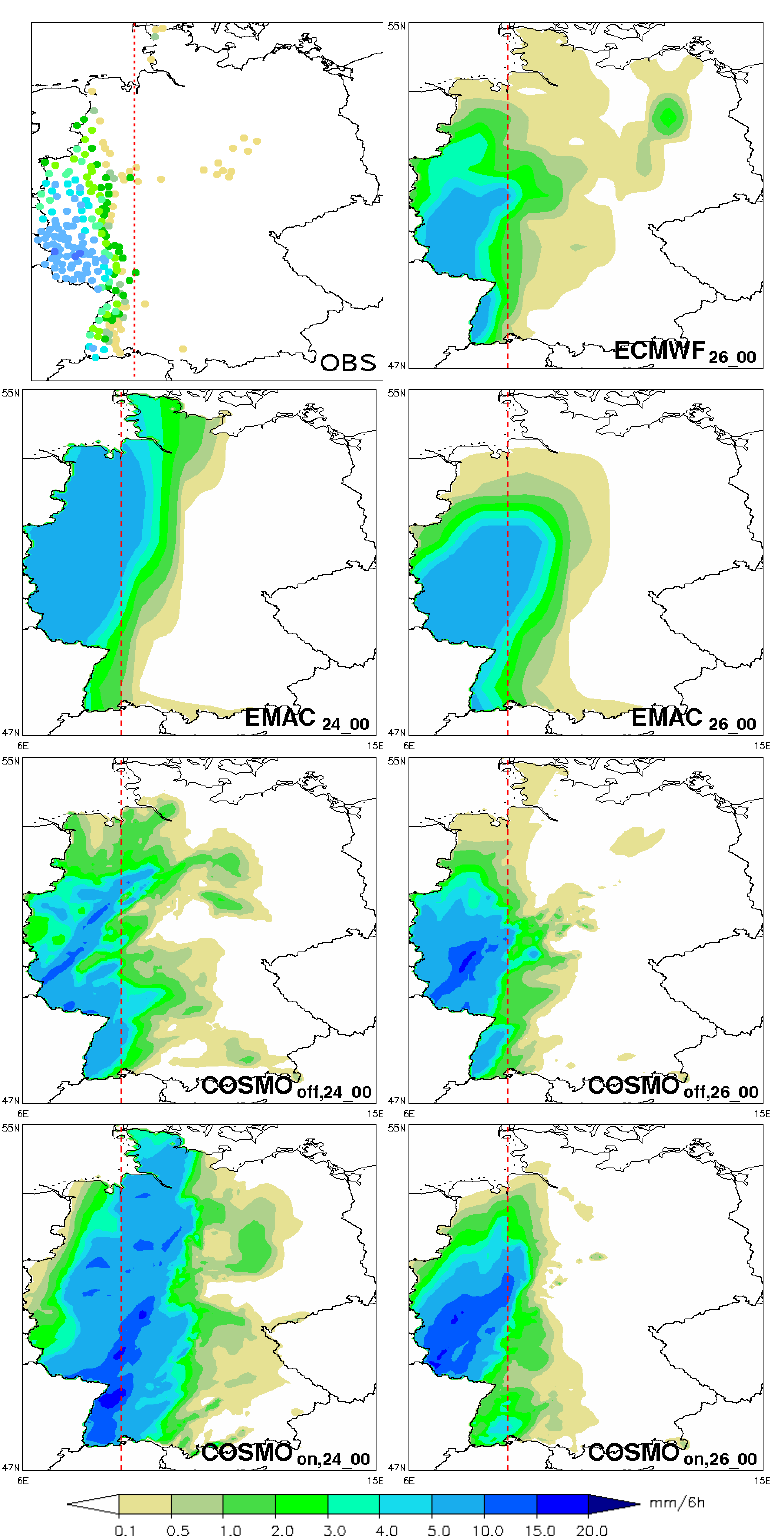
Fig. 6. 6h-accumulated precipitation for 06:00–12:00UTC, 26 March 2010 for different simulations and rain gauge observations (top left panel). The red dashed line enables a better comparison between the location of the precipitation fields.